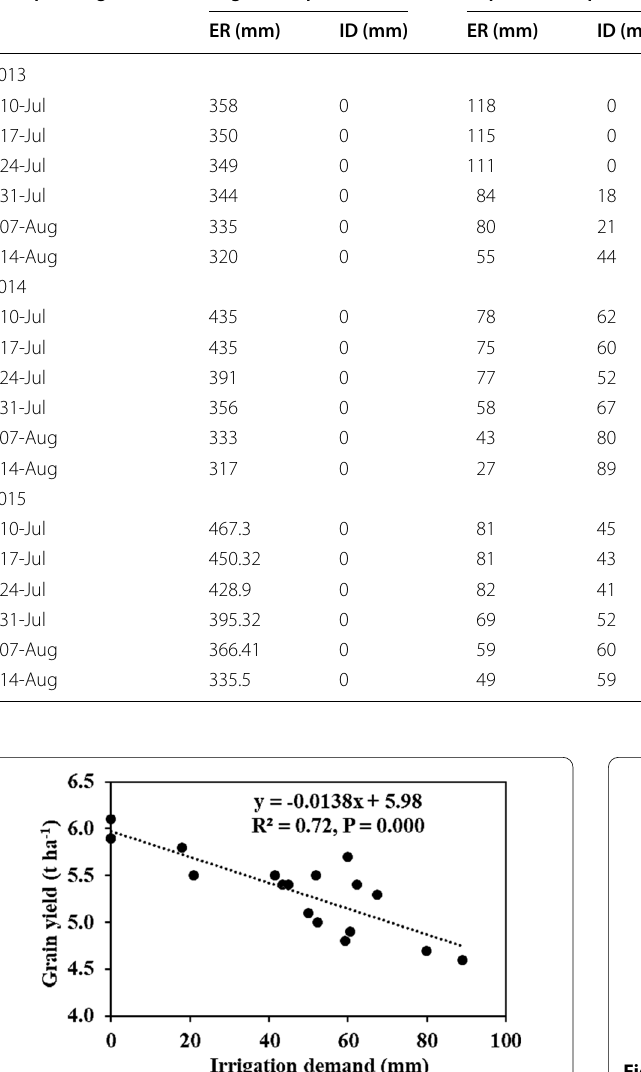
Fig. 4 Relationship between grain yield and irrigation demand of BR11 at ripening phase in Kushtia during T. Aman,